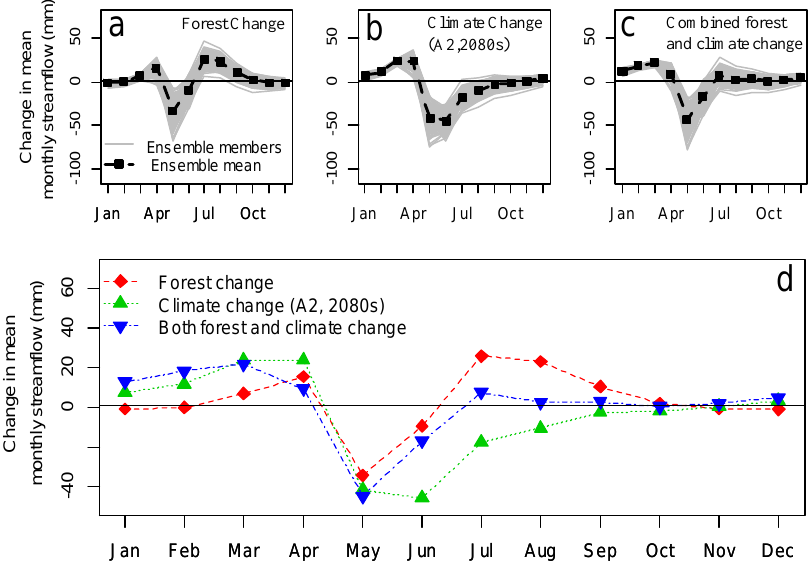
Fig. 11. Ensemble and mean values of relative changes in mean monthly streamflows: (a) due to forest removal, (b) due to climate change in 2080s in A2 scenario, and c) due to combined forest removal and climate change in 2080s in A2 scenario. Figure 9d shows the ensemble mean to compare the relative changes in mean monthly streamflows due to forest removal, due to climate change in 2080s in A2 scenario and due to combined forest removal and climate change in 2080s in A2